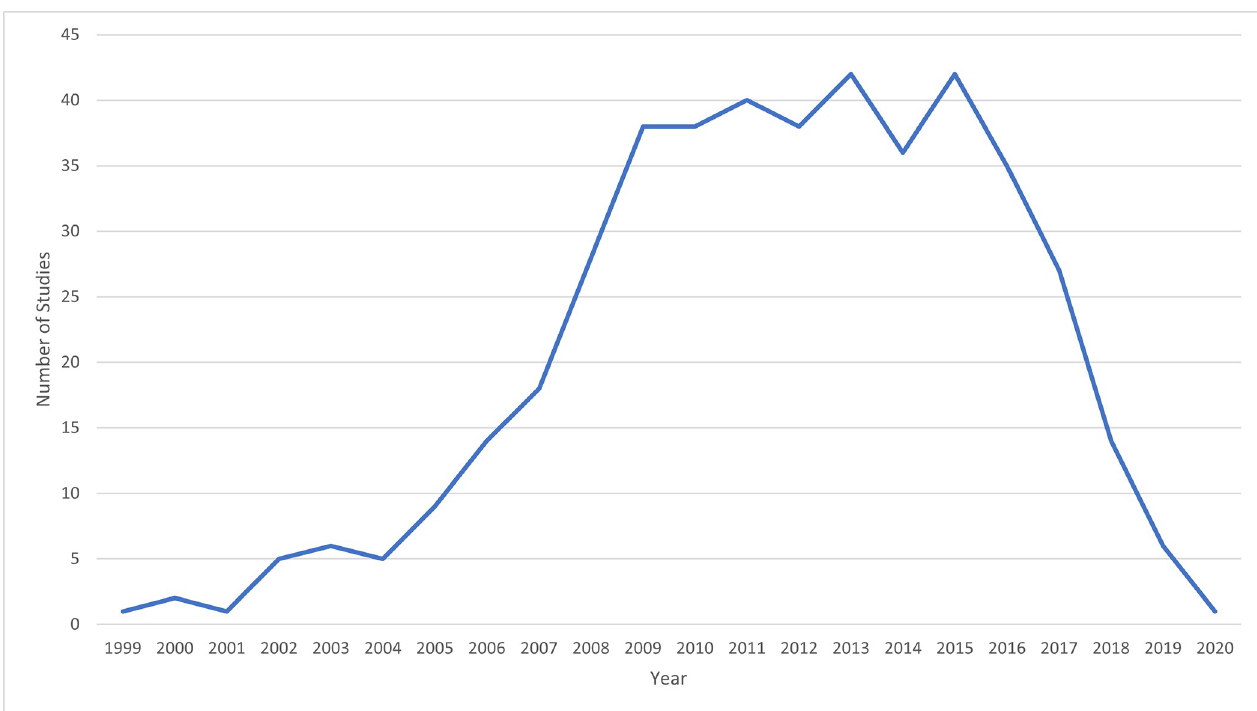
Fig 3. Number of studies collecting data by year (n = 155). Note that if a study collects accelerometry over multiple years, then it is included on the graph in each of those years.